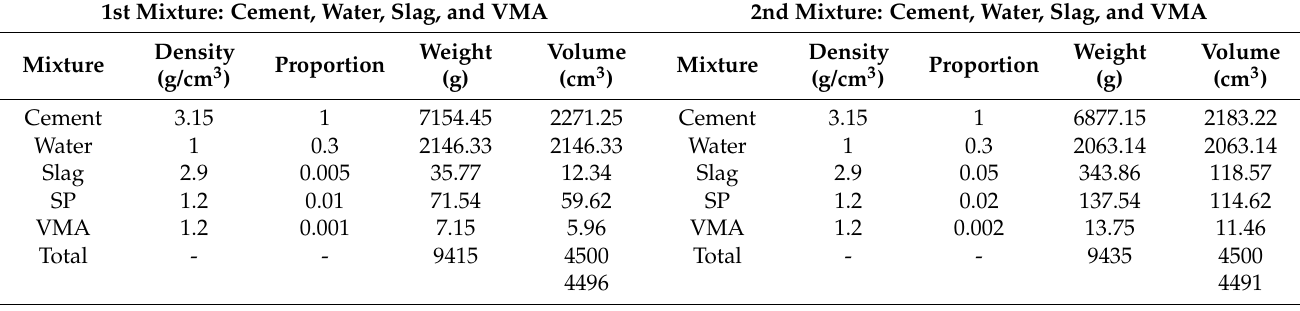
Table 5. Mix proportions of the grouting